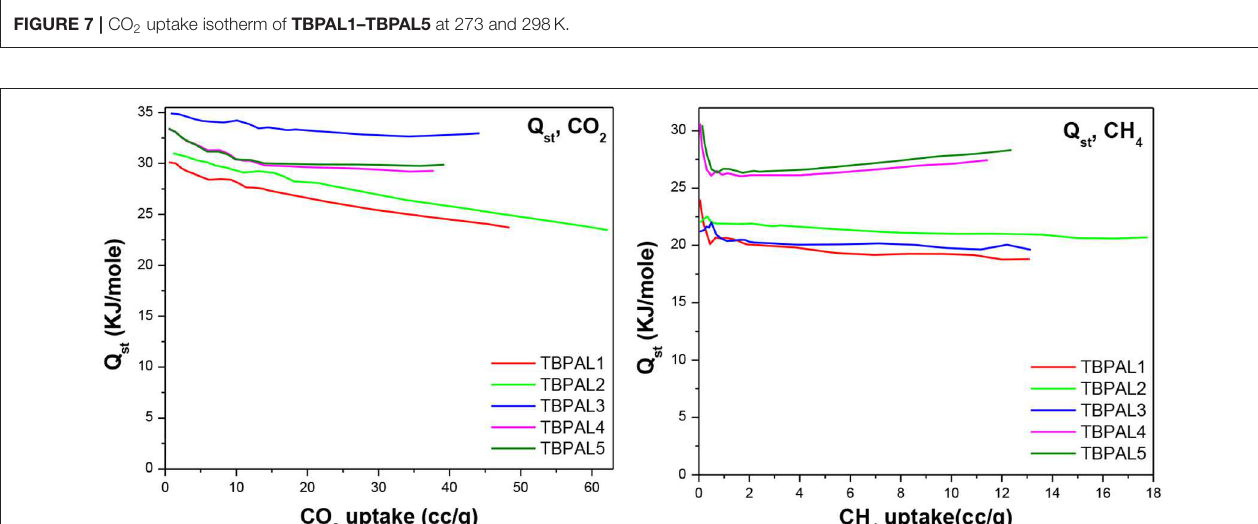
FIGURE 8 | Q st of TBPALs for CO 2 (left) and for CH 4